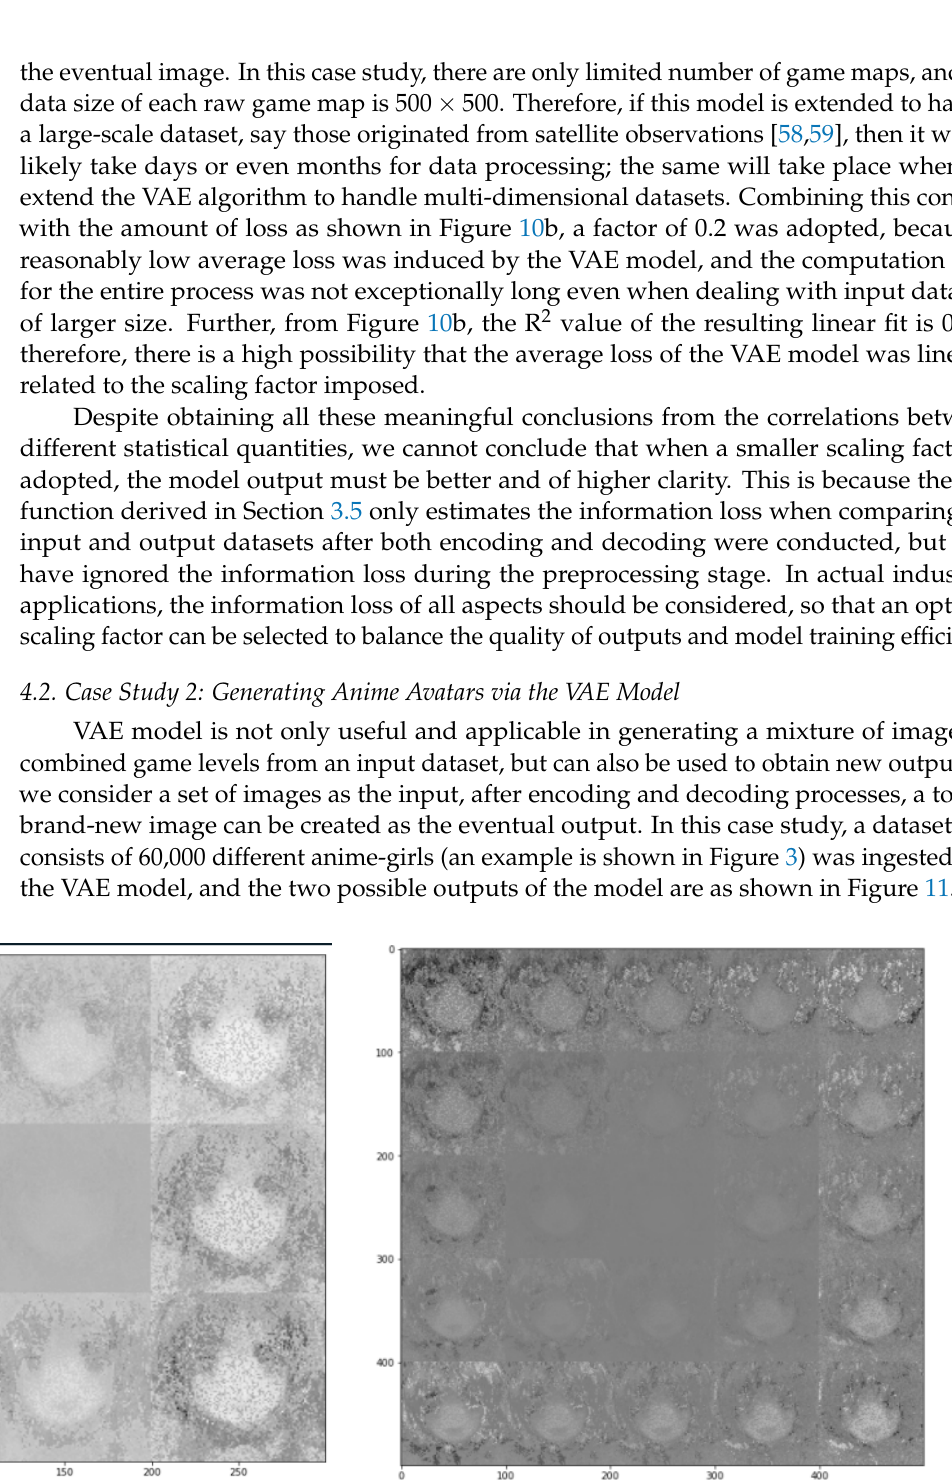
16 of 24 Figure 10. ( a ) Time consumed for ten image-generation process (in s) versus scaling factor imposed in the model; ( b ) Average loss of the ten image-generation process versus scaling factor imposed in the model. As observed, the time consumption was not linearly related to the scaling factor imposed in the VAE model. Instead, the plot shown almost converges to a quadratic or exponential relationship. Nevertheless, as the scaling factor increased from 0.2 to 0.3, the